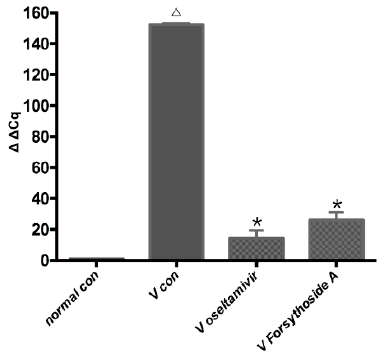
Figure 4. Effect of forsythoside A and oseltamivir on changing the relative expression levels of the IAV replication. Total RNA was isolated from the lung tissue. Statistics determined by two-part t test. Δ p < 0.01 compared with normal con . * p < 0.01 compared with V con .